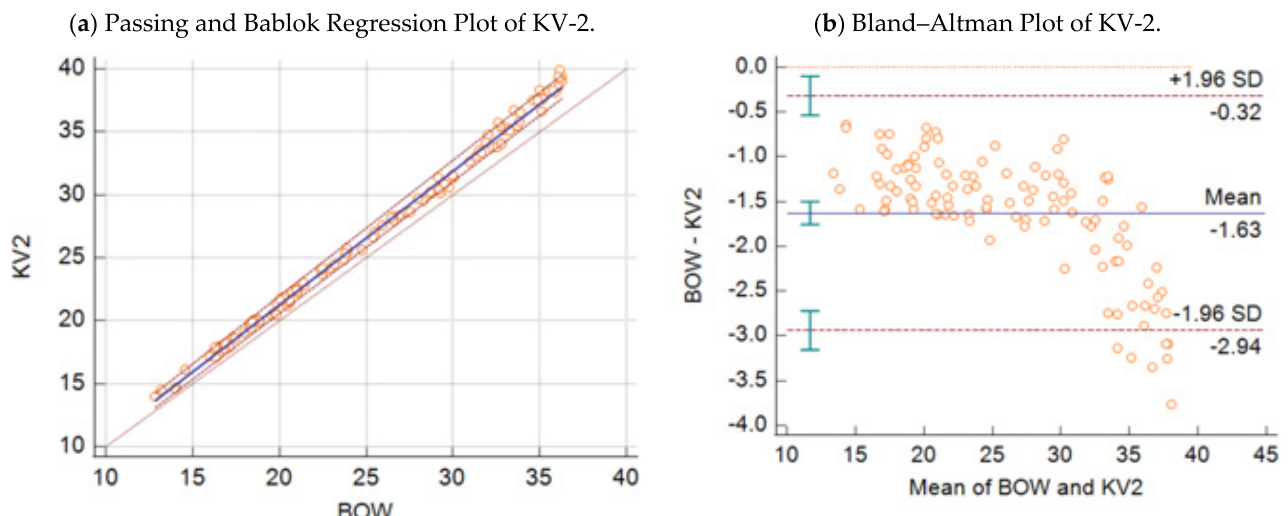
Figure 1. ( a ) Passing–Bablok regression plot: comparison of Ct values obtained with the wild-type KV-2 strain assay vs. CaPV-specific real-time PCR Bowden assay, with 95% CI in 109 samples. ( b ) Bland–Altman plot: comparison of Ct values obtained with the wild-type KV-2 strain assay vs. Capripox-specific real-time PCR Bowden assay, with 95% CI in 109 samples.